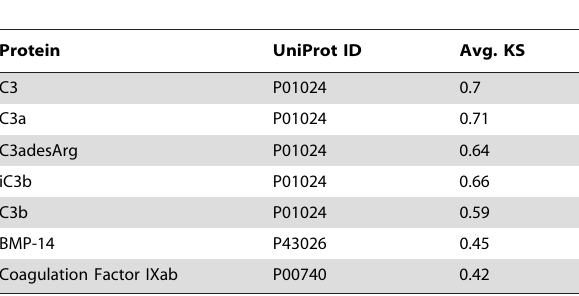
Table 10. Proteins with Preanalytical Variability 1